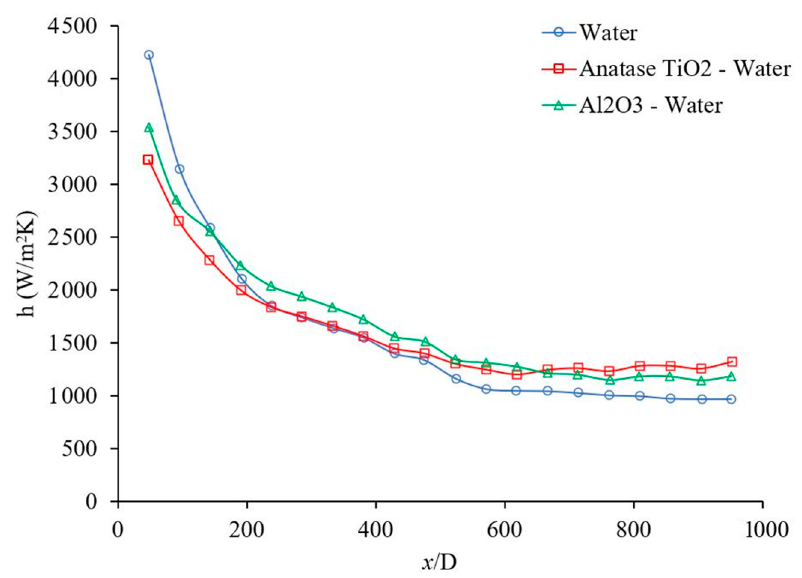
Figure 11. Variation of heat transfer coefficient as a function of distance for Al 2 O 3 –water and TiO 2 – water nanofluids. Nanofluid concentration was 1 wt %, and the range of Reynolds number inside the microchannel was 150–200. The Al 2 O 3 and anatase TiO 2 nanoparticles were commercial.